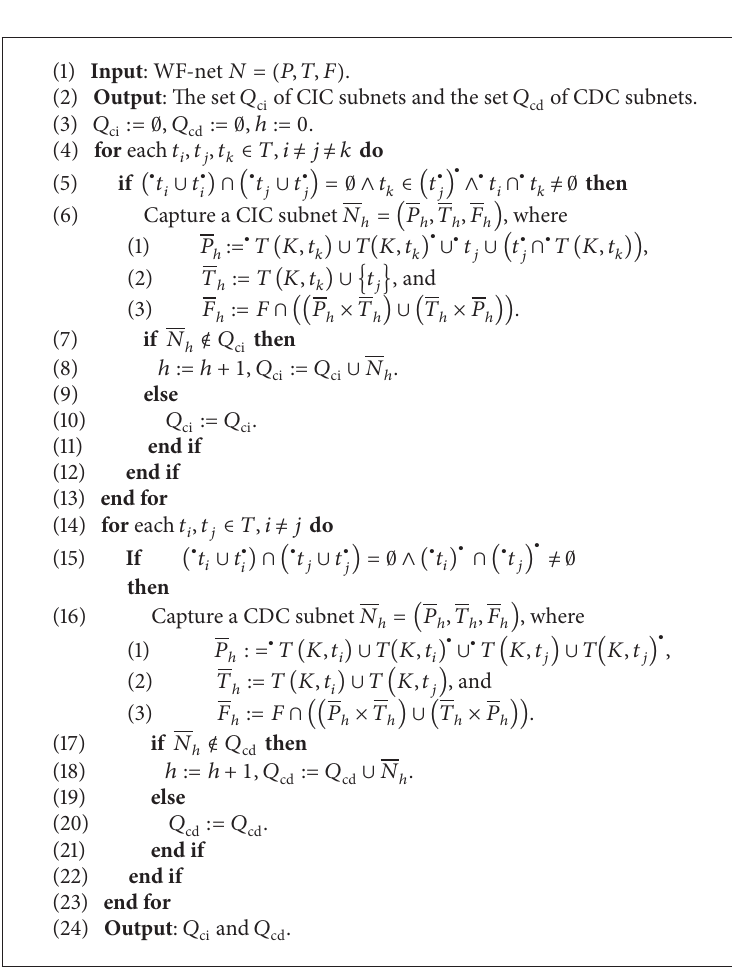
Algorithm 1: Detection of confusion subnets in WF-net 𝑁